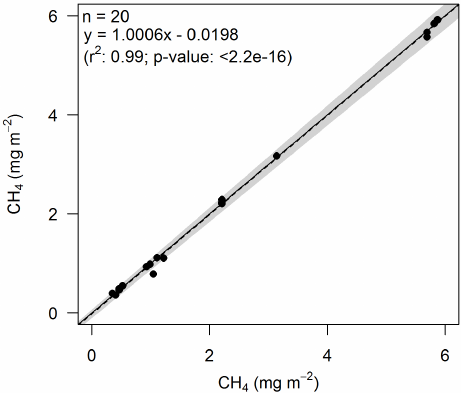
Figure 4. Scheme of experimental setup used for the simulation and determination of ebullition events with a Los Gatos fast greenhouse gas (FGG) analyser (911-0010, Los Gatos). The crimped area rep- resents water-filled tub.